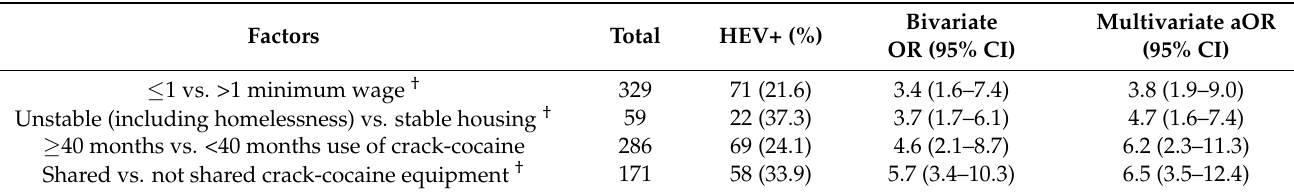
Table 3. Factors associated with hepatitis E virus exposure in people who use crack-cocaine in a remote region of northern Brazil. Factors Total HEV+ (%) ≤ 1 vs. >1 minimum wage